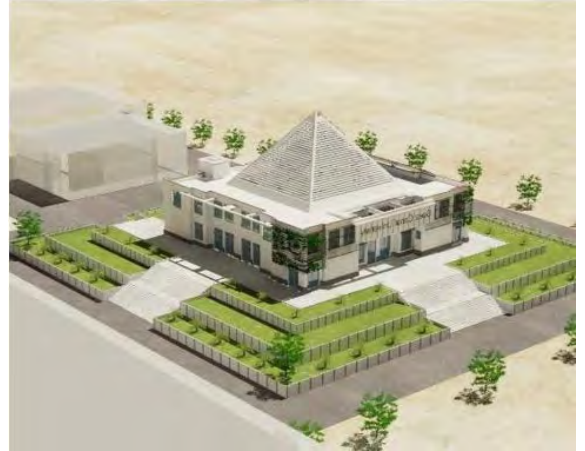
Figure 10. B-south east shot